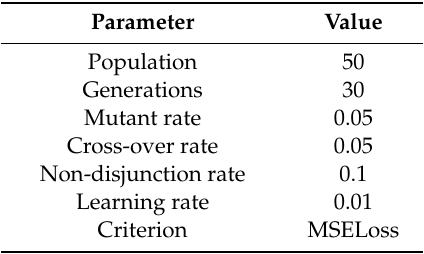
Table 2. Parameters of experiment.